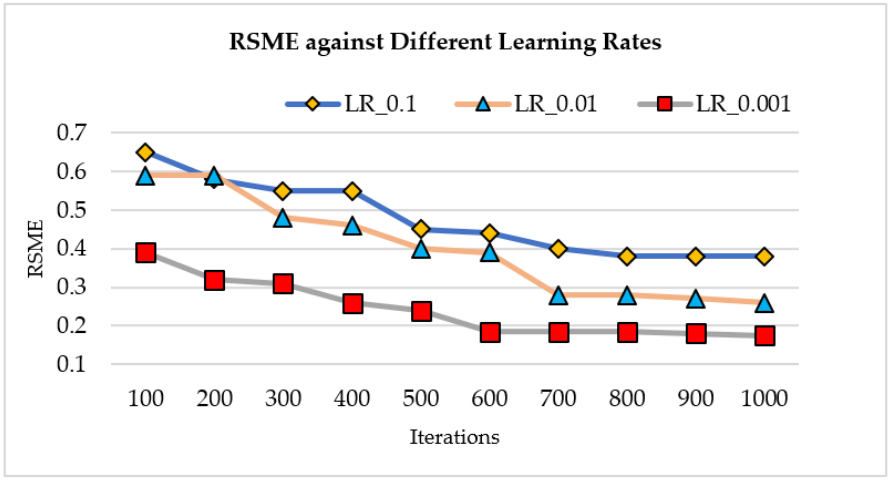
Figure 9. Testing error against different learning rates.